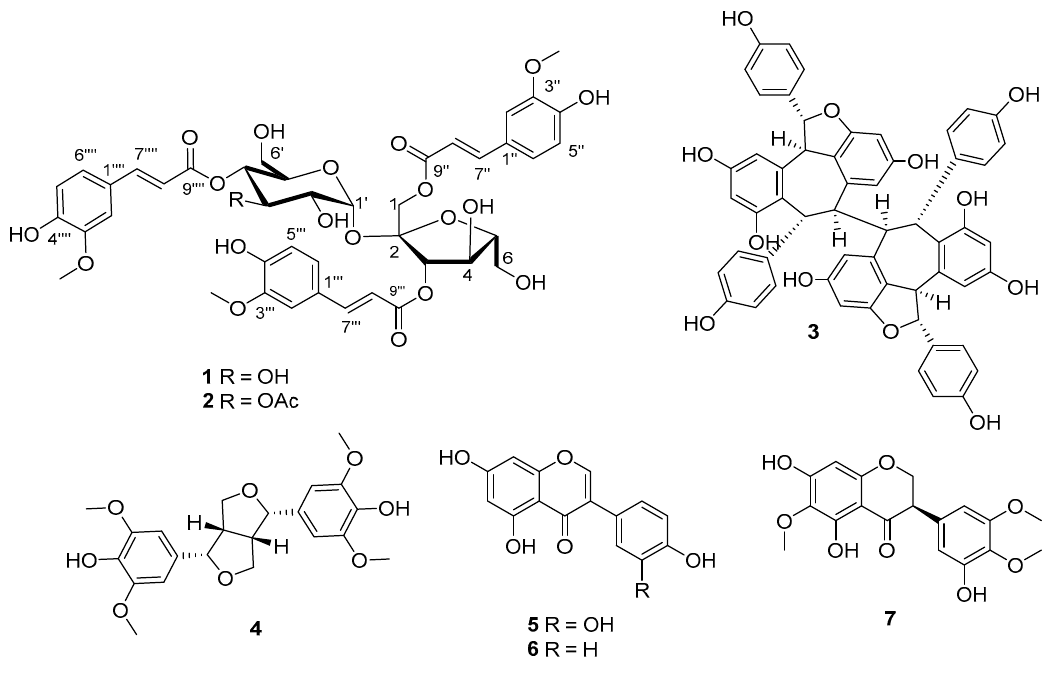
Figure 1. Chemical structures of compounds 1 − 7 .